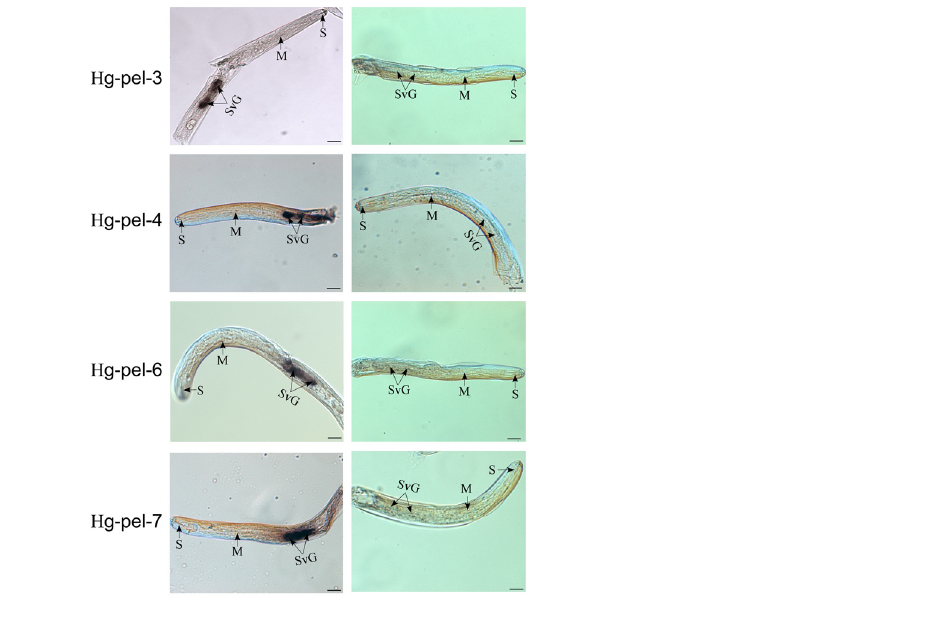
Fig 4. Localization by in situ hybridization of hg-pel-3 , hg-pel-4 , hg-pel-6 and hg-pel-7 in pre-parasitic second stages of Heterodera glycines . Left panel: antisense Hg-pel-3 , Hg-pel-4 , Hg-pel-6 and Hg-pel-7 probes; right panel: corresponding sense probes. S, stylet; M, median bulb; SVG, subventral esophageal cell. Scale bar: 20 μ